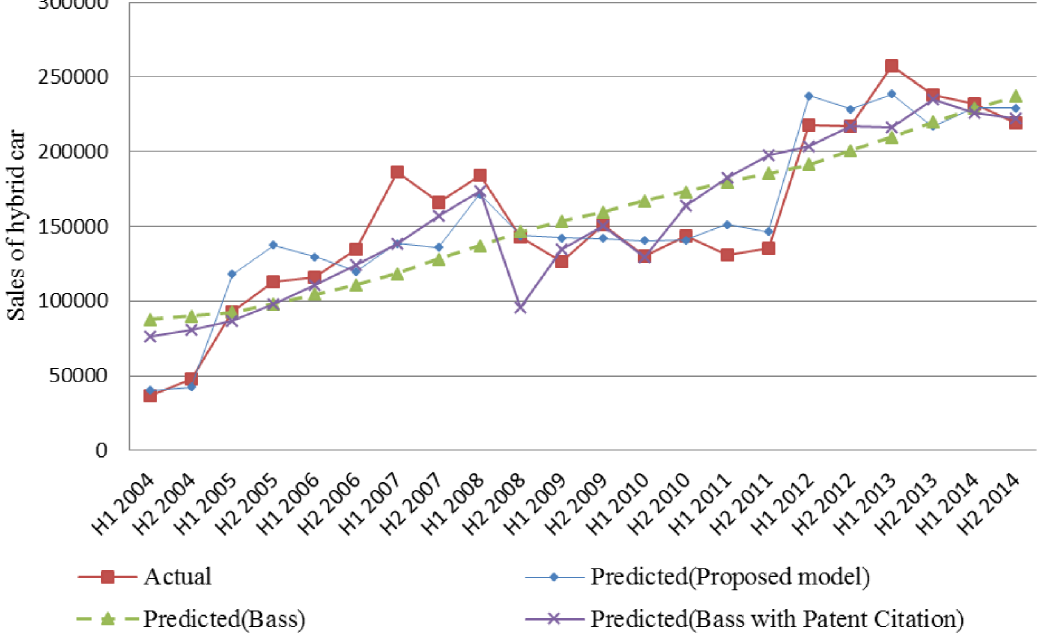
Fig 1. Comparison of actual and predicted sales of hybrid